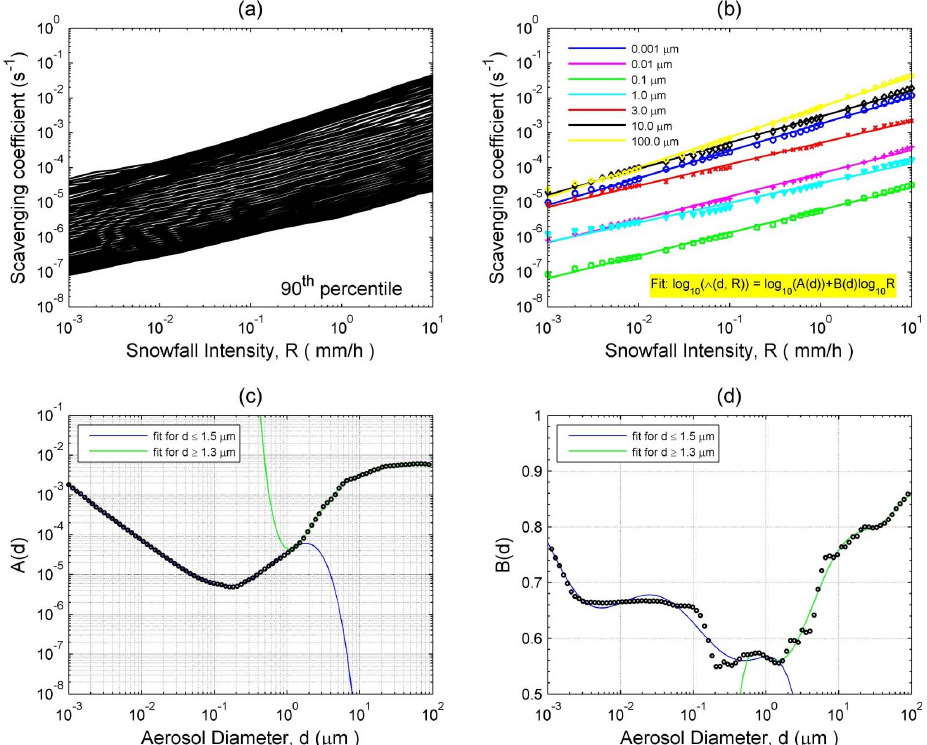
Fig. 5. Same as in Fig. 2 except for 3 snow .